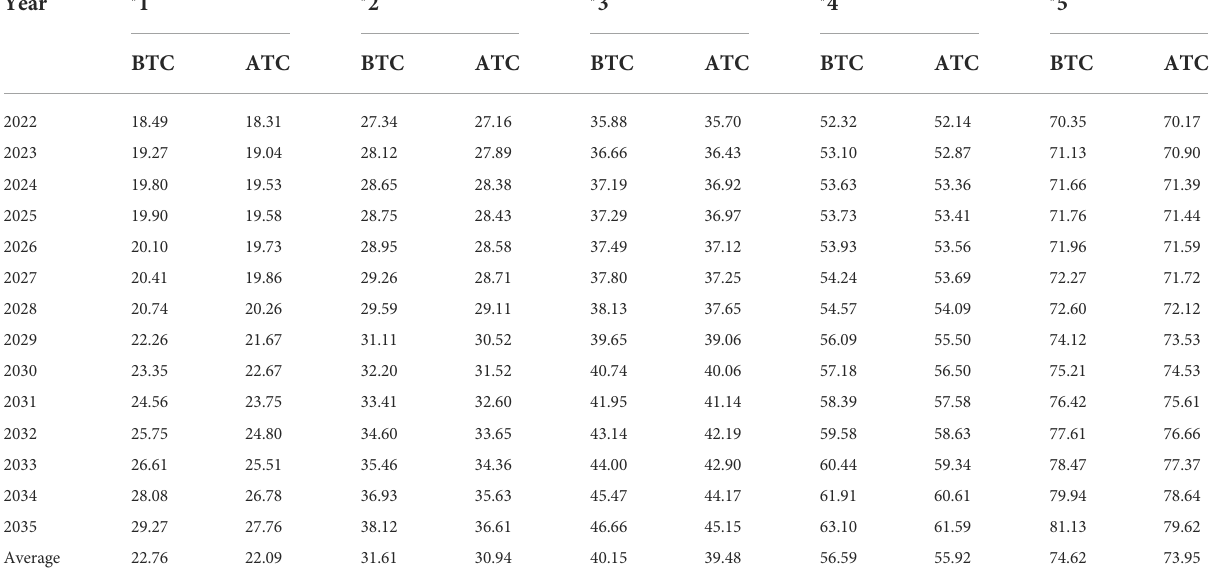
TABLE 6 The prediction results of the HODR for the fi ve selected households in 2022 – 2035